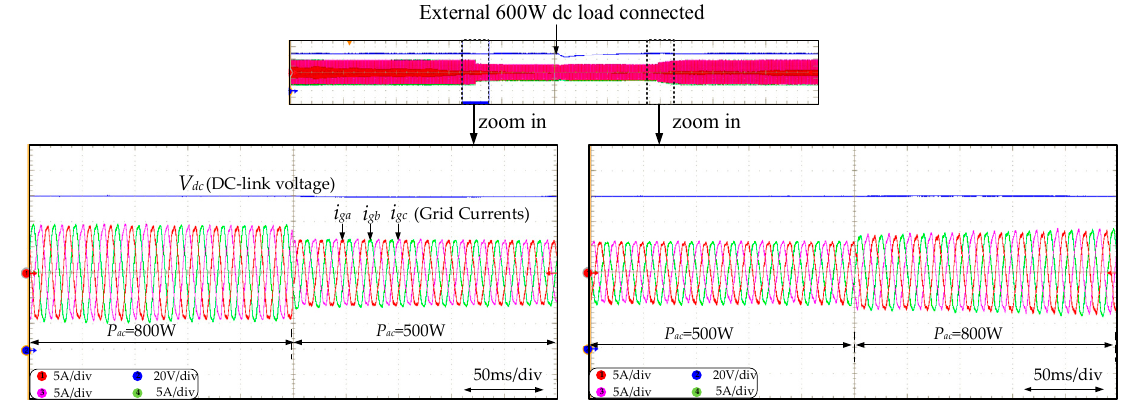
Figure 19. Experimental waveforms’ dynamic performances of rectifier mode operation with proposed control strategy.